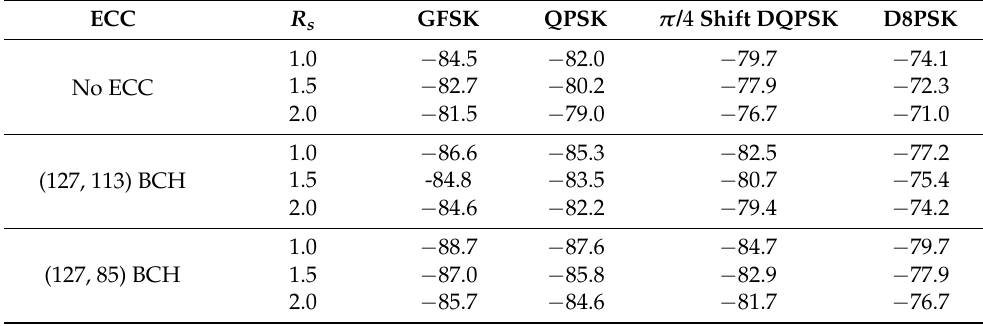
Table 10. Examples of S dBm (dBm). PER ≤ 10 − 2 , L PSDU = 127 bytes, NF dB = 13 dB and I dB = 6 dB.